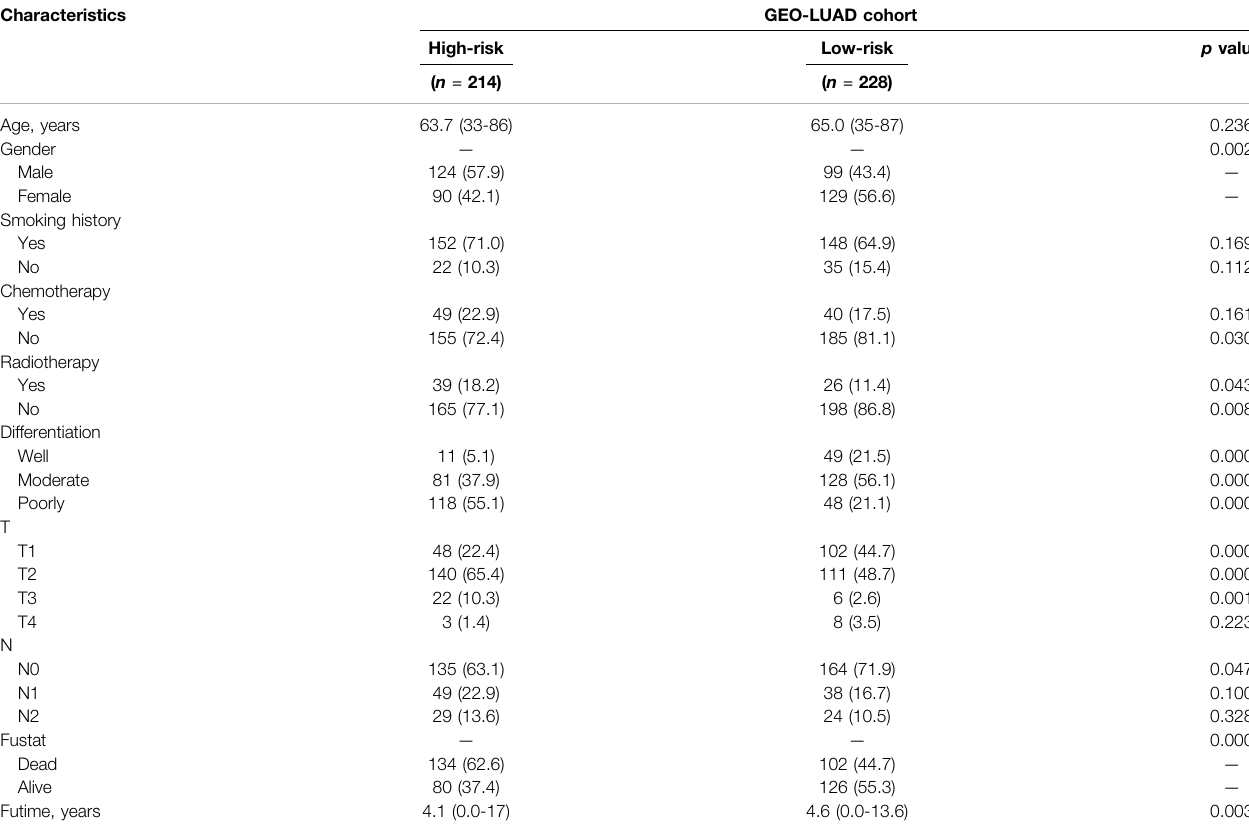
TABLE 2 | Characteristics of two risk group patients in GEO LUAD cohort.